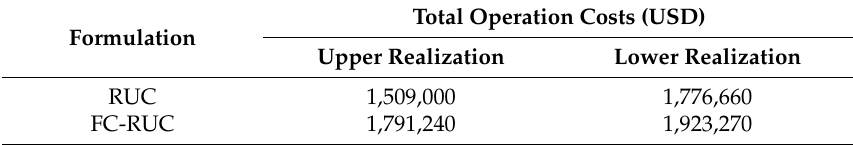
Table 3. Total operation costs for each realization of VGT. Comparison between Robust